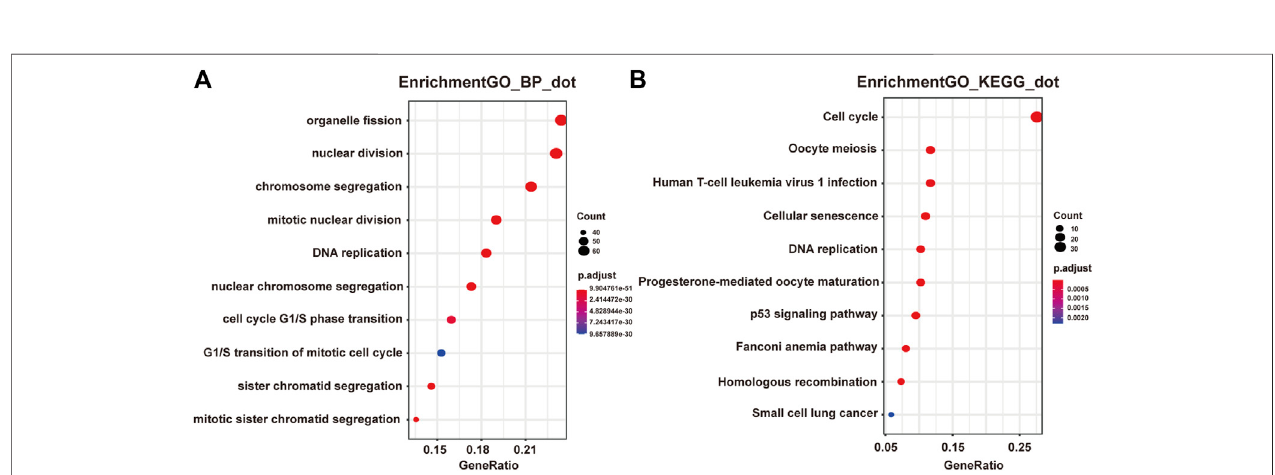
FIGURE2| Functionalenrichmentanalysis ofgenesinthepink module. (A) GOanalysisshowed thetop 10enriched biologicalprocesses in thepinkmodules. (B) KEGG analysis showed the top 10 enriched pathways in the pink modules.